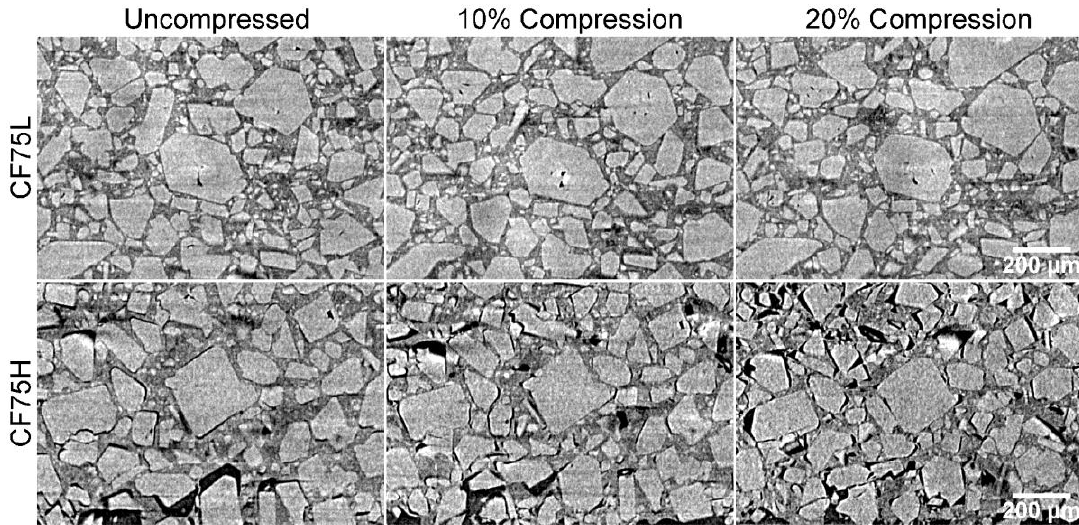
Figure 5. Selected regions of CF75L and CF75H from Figure